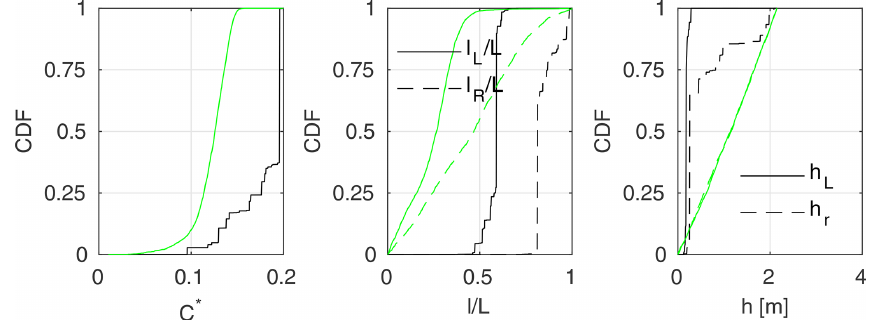
Figure 18. Marginal a posteriori distributions of STLM model parameters, identified using m = M observation points in the Ritobacken case study; black lines stand for the autumn 2011 set and green lines for spring